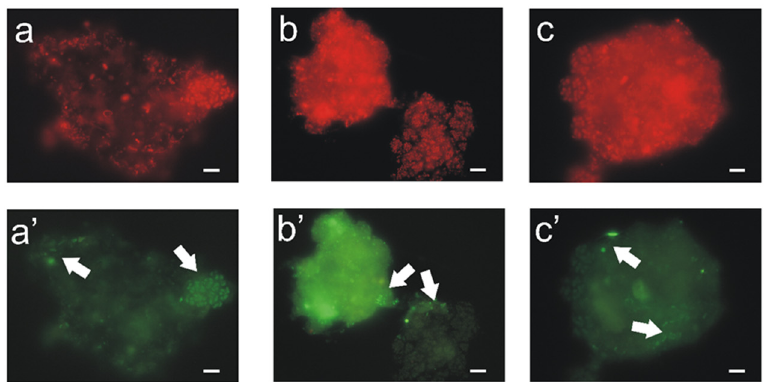
Figure 8. Fish hybridization of bacteria from the IFAS reactor. Most bacteria identified with the EUB338 probe ( a – c ) and ammonia-oxidizing β -proteobacteria ( a’ – c’ ) in activated sludge ( a , a’ ), in biofilm from the outer surface of the biotextile ( b , b’ ), and at the outflow ( c , c’ ). Scale bar: 10 μ m.